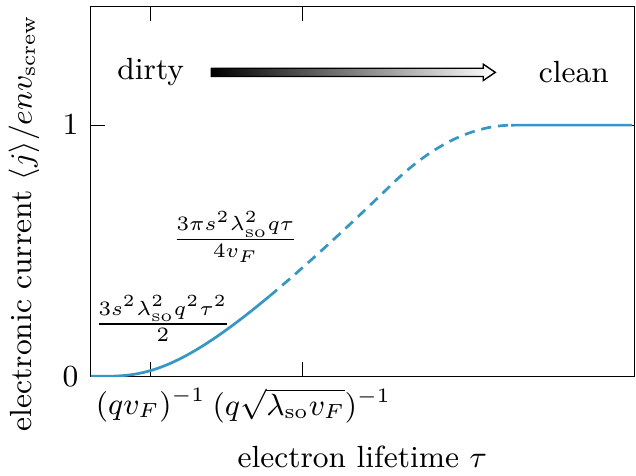
Figure 9: Schematic plot of the electronic current density 〈 j (cid:107) 〉 as a function of electron lifetime τ . Note that we have suppressed the spin indices, which is jus- tified for a strongly spin polarized system N ↑ (cid:29) N ↓ . For a strongly disordered ) − 1 , 〈 j 〉 = 3 s 2 λ 2 so q 2 τ 2 system, when τ (cid:28) ( qv is quadratic in τ . In the range (cid:107) F (cid:112) 2 ) − 1 , 〈 j 〉 grows linearly with τ . Our perturbative assump- ( qv ) − 1 (cid:28) τ (cid:28) ( q v (cid:107) F F tions break down in the dashed region, but we know that for a very clean system with no disorder ( τ (cid:29) 1 ) the current must plateau at 〈 j (cid:107) 〉 = env screw